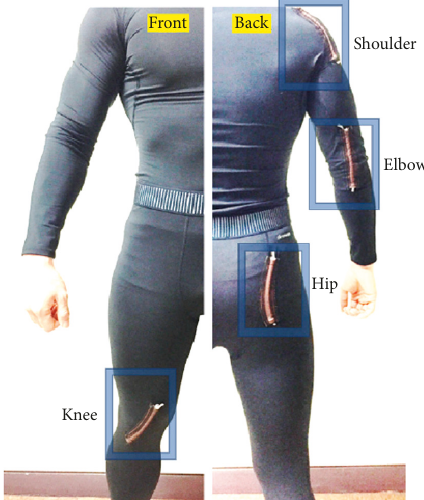
Figure 2: A view of the garment with an energy harvesting system using the piezoelectric effect (reproduced from Kim et al. [8], under the Creative Commons Attribution License/public domain).